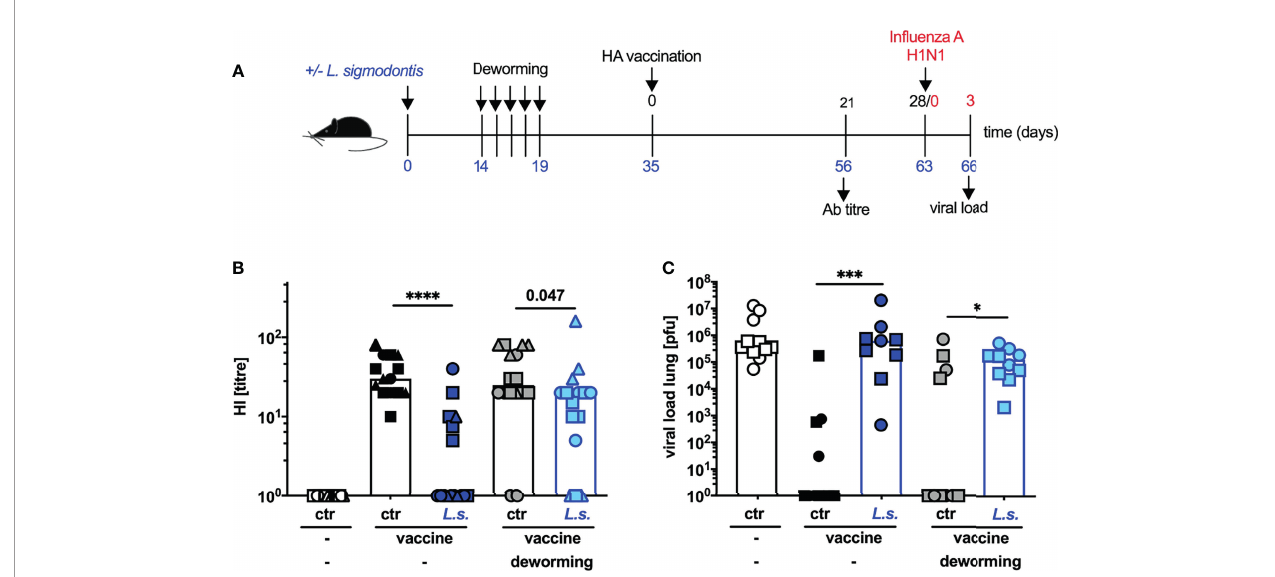
FIGURE 2 | Deworming 2 weeks before vaccination against in fl uenza results in partial restoration of neutralizing Ab response but does not confer protection. (A) Experimental design: C57BL/6 mice were left naive (white, black and grey symbols) or naturally infected with L. sigmodontis (dark and light blue symbols). Mice were dewormed by daily s.c. FBZ injection FBZ (grey and light blue symbols) for 5 consecutive days on day 14 p.i. until day 19 p.i. or were left untreated. Deworming ef fi cacy is shown in Supplementary Figure S1 . Mice were i.p. vaccinated with non-adjuvanted in fl uenza vaccine Begripal at day 35 post L. sigmodontis infection or were left unvaccinated (white symbols). (B) HI titres were quanti fi ed 21 days after vaccination. (C) All mice were i.n. infected with 1 x 10 3 PFU 2009 pH1N1 in fl uenza A virus 7 days later. In fl uenza virus burden in the lungs were quanti fi ed day 3 post challenge infection. Shown are combined results from 3 independent experiments with n ≥ 3 (B) per group and experiment or combined results from 2 independent experiments with n ≥ 5 (C) per group and experiment. Each symbol represents an individual mouse, squares, circles and triangles represent independent experiments, the bars show the median. Asterisks indicate statistically signi fi cant differences applying Mann-Whitney test (* p ≤ 0.05, *** p ≤ 0.001, **** p ≤ 0.0001, numbers indicate p -values). ( L. sigmodontis , Litomosoides sigmodontis ; s.c., subcutaneous; FBZ, Flubendazole; p.i., post infection; i.p., intraperitoneal; HI, hemagglutination inhibition; i.n., intra nasal; PFU, plaque forming